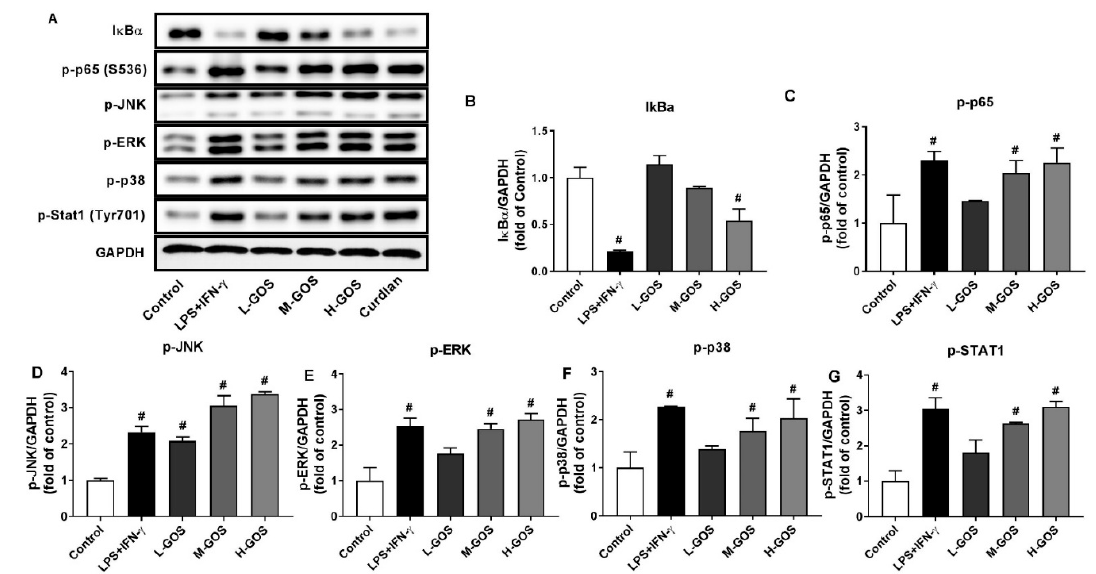
Figure 5. Western blotting of protein expression ( A ) and accordingly the densitometry quantification of the expressed protein bands I κ B α ( B ), p-p65 ( C ), p-JNK ( D ), p-ERK ( E ), p-p38 ( F ), and p-Stat1 ( G ) in BMDMs after GOS (25 − 100 µg/mL) treatment. Results were expressed as the mean ± SD of three replicates. # —Indicated significant difference versus the control group at p < 0.05.